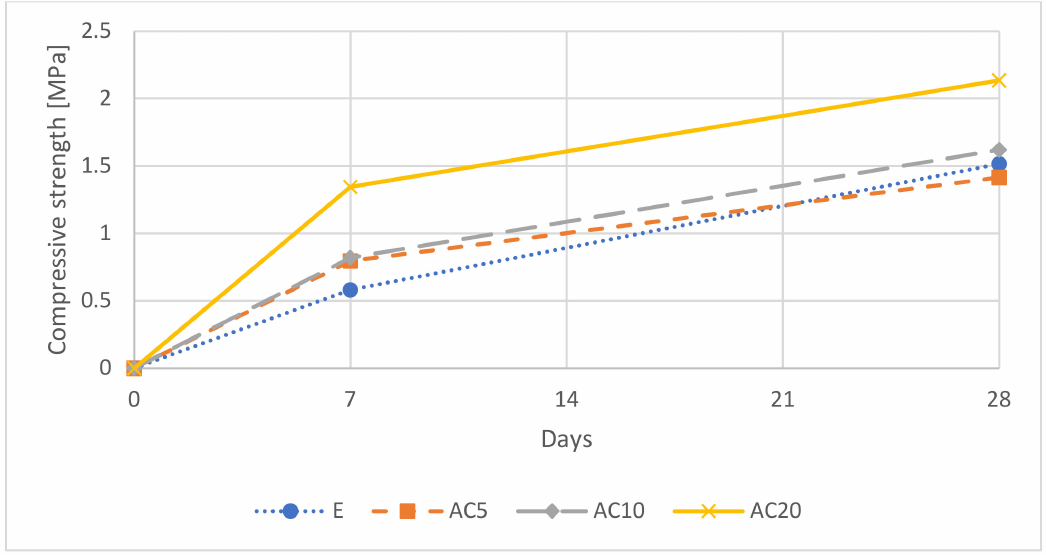
Figure 4. Development of compressive strength from 7–28 days in Series 3 (varied w/b ratio and percentage of WPC, 0.4% AEG agents added).